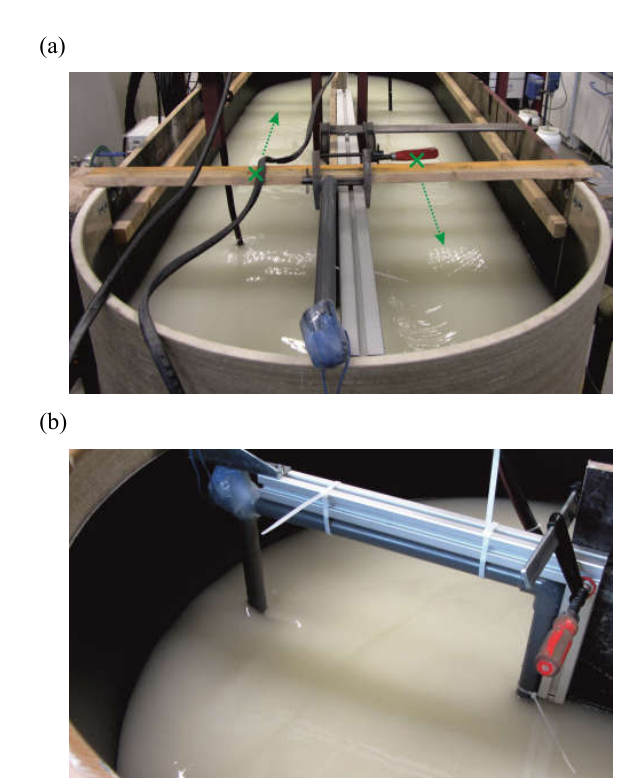
Figure 7. Lab-scale biogas digester with oval geometry and an in- stalled coil as a position marker. The horizontal positions of the two impellers and the main flow direction are marked in (a) .